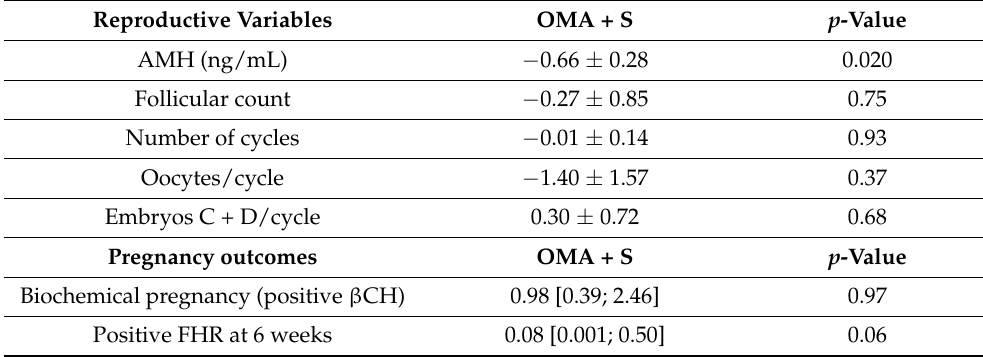
Table 5. Associations of endometriosis with reproductive and pregnancy outcomes. Reproductive